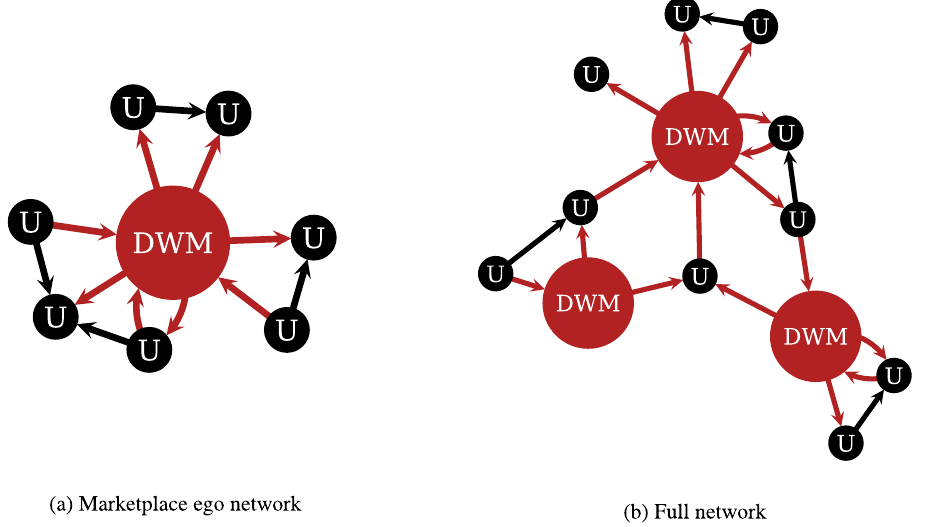
Figure 1. Ego and full networks. ( a ) Schematic representation of an ego network surrounding a dark web marketplace (“DWM”, in red). The DWM interacts with its users (“U”, in black). User-to-user (U2U) pairs are represented by arrows (direction indicates the flow of Bitcoin) and by their respective users. ( b ) Multiple ego networks may be aggregated to form the full